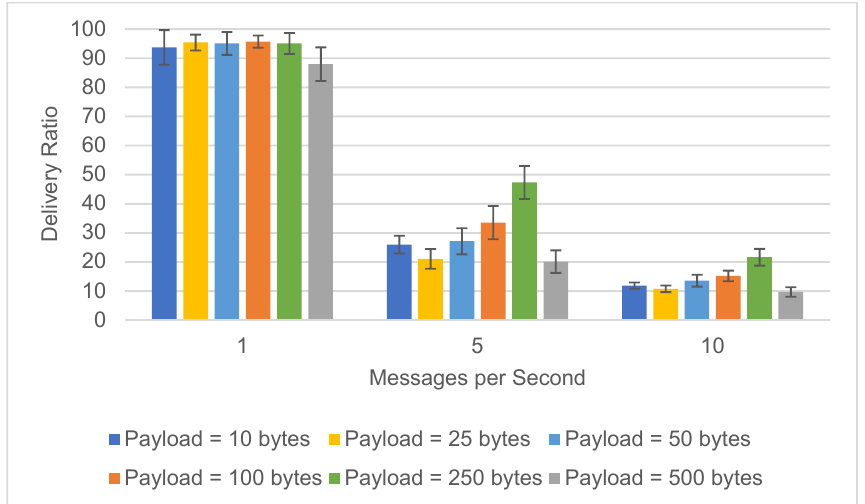
Figure 15. Delivery ratio (%) of messages (4 sensors and 1 destination).